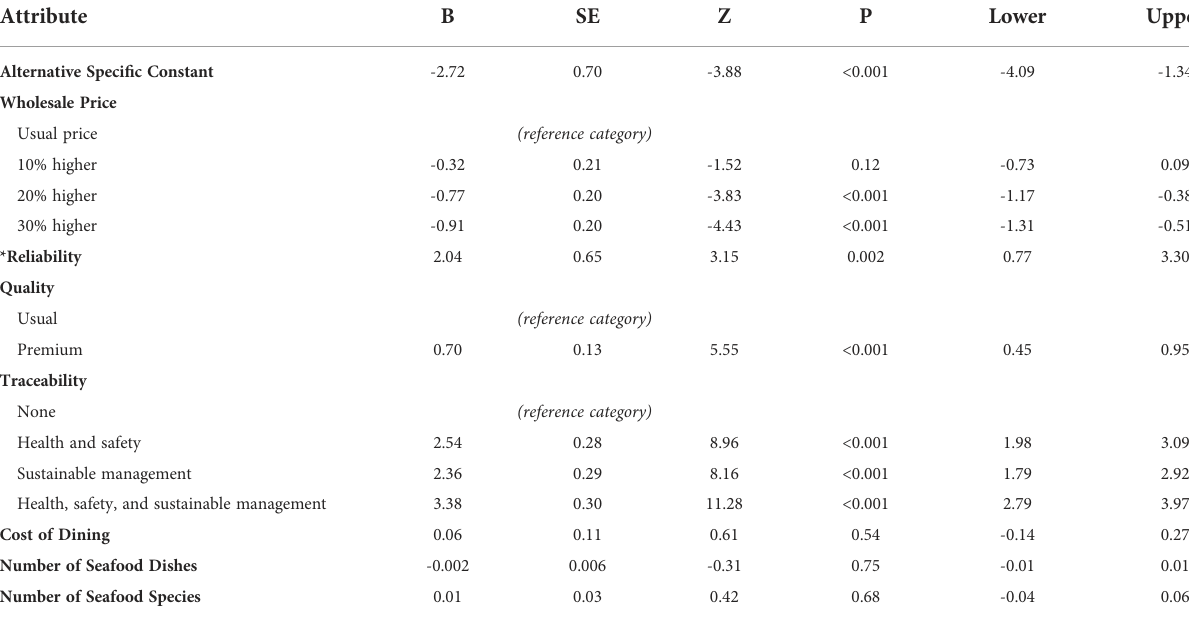
TABLE 4 Parameter estimates (mean and standard error) of the random parameter logit model.